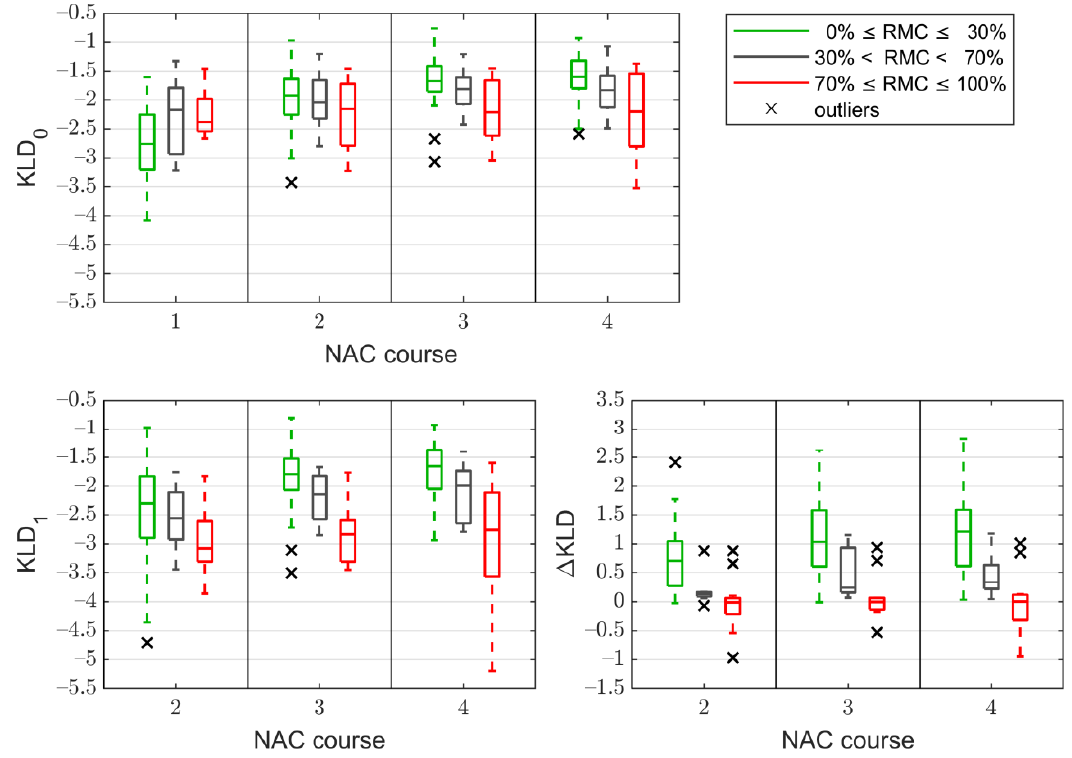
Figure 6. Statistics of the kld-based parameters: KLD 0 (top), KLD 1 (bottom left), and ∆ KLD (bottom right), after subsequent courses of neoadjuvant chemotherapy (NAC). The tumors are divided into responding (RMC ≤ 30%), partially-responding (30% < RMC < 70%), and non- responding (RMC ≥ 70%) (RMC— Residual Malignant Cell).